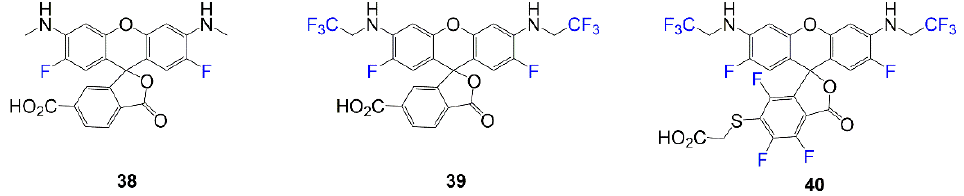
Figure 8. Precursors to targeting probes [44].